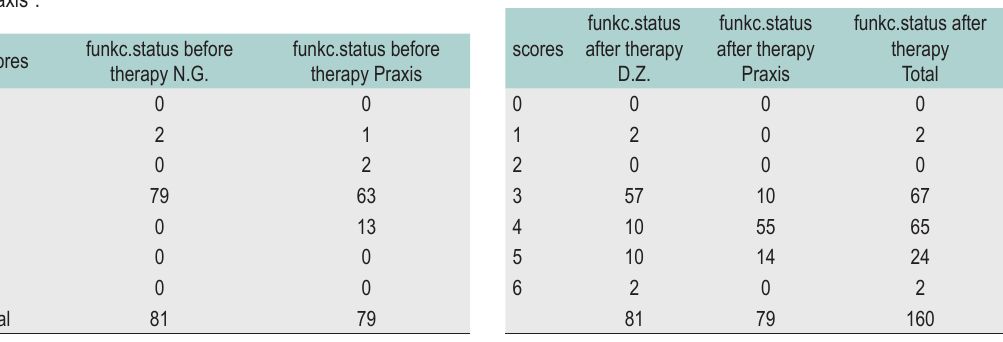
TABLE 7. Functional status after therapy in respondents